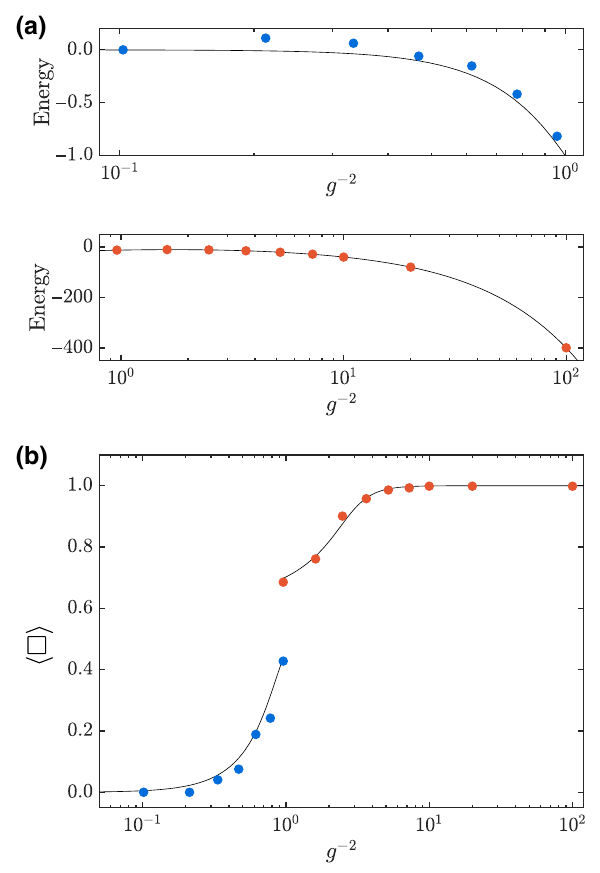
FIG. 7. The classical simulation of the proposed experiment for observing the running of the coupling (see Sec. V B) using the circuits given in Fig. 6. The red and blue data points are obtained from variational minimization with a total finite mea- surement budget of 6 × 10 5 measurements for the entire plot. The electric (magnetic) representation is shown in blue (red) and the black solid lines are determined via exact diagonaliza- tion of the Hamiltonians in Eqs. (4) and (5). (a) The energy of the variational ground state using the electric representation in the region g − 2 < 1 and using the magnetic representation in the region g − 2 > 1. (b) The plaquette expectation value (cid:8) (cid:2) (cid:3) as a function of g − 2 . All dots are calculated using the exact state cor- responding to the optimal variational parameters found by the